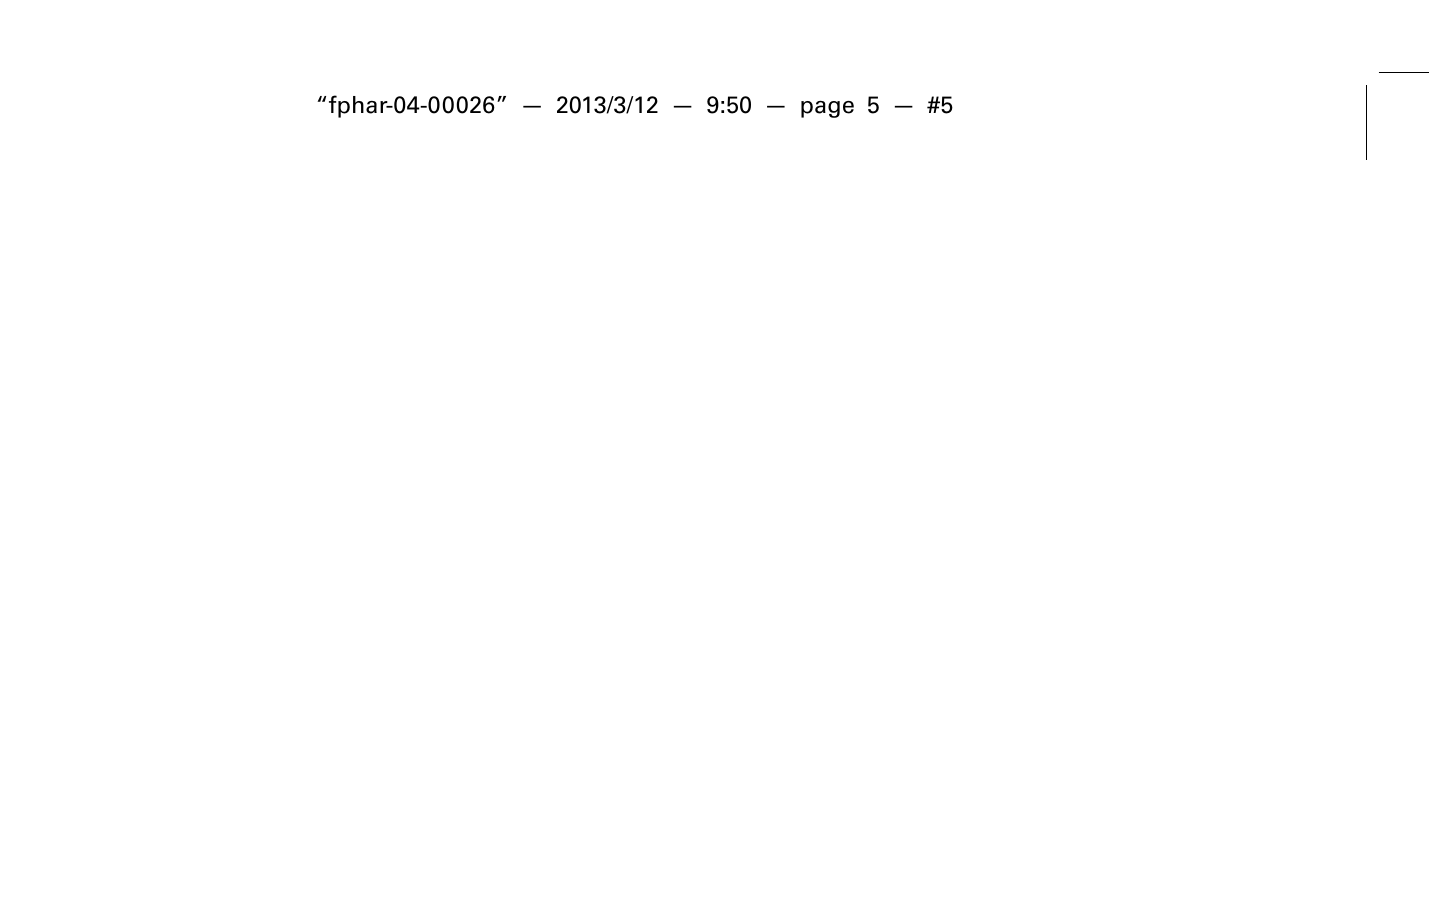
FIGURE 3 |Adherence report over 2 weeks after the intervention (December 2010). The y -axis reflects local time after adjusting for wintertime ( − 1 h). A punch card was handed out everyThursday afternoon, with the first